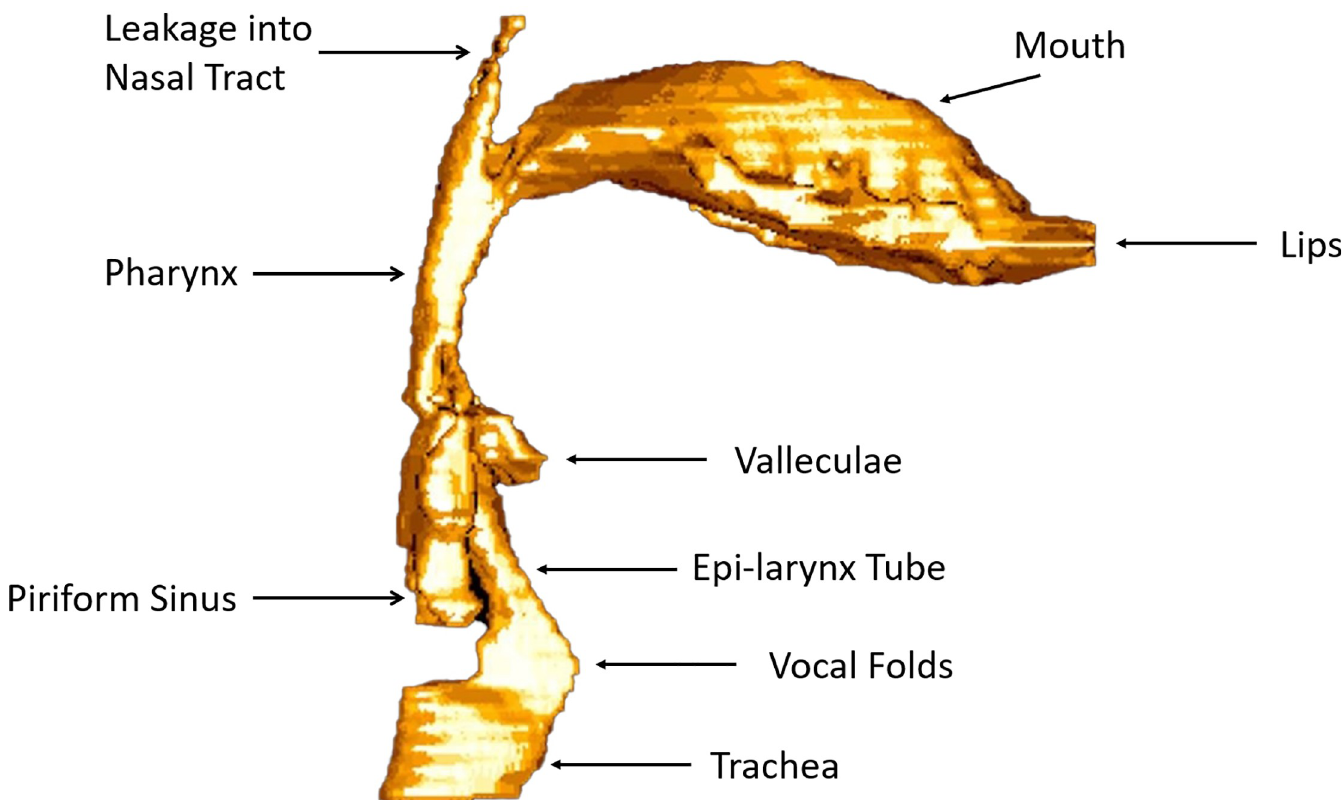
Fig 1. Mid-sagittal MRI scan of a male human airway in an / ɑ / vowel configuration. (after Story B, et al.) [33].